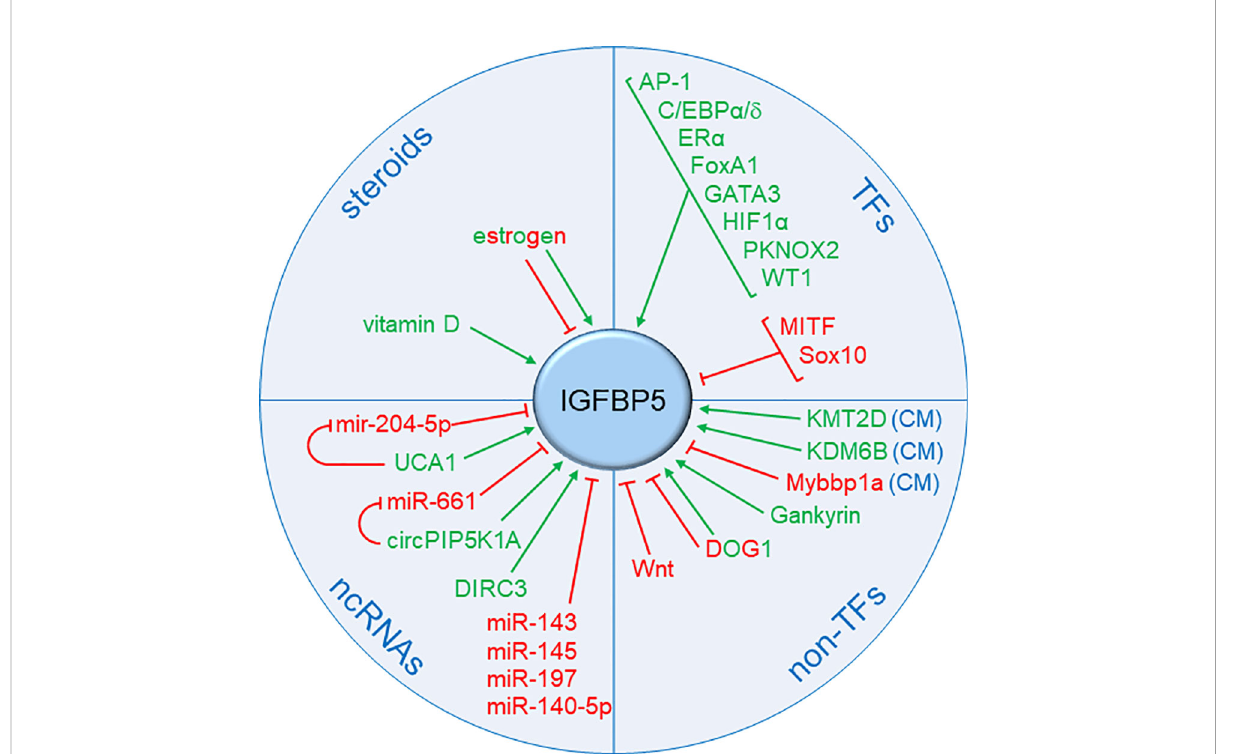
FIGURE 4 Summary of known factors regulating IGFBP5 expression. Besides proteins that regulate IGFBP5 transcription, namely transcription factors (TFs) (see also Figure 5) and chromatin modi fi ers (CM), other factors have been identi fi ed that interfere with IGFBP5 expression. These include other proteins (Wnt, DOG1, Gankyrin), steroids and non-coding RNAs (ncRNAs), namely microRNAs (miRs) and long noncoding RNAs (lncRNAs). Factors that stimulate IGFBP5 expression are denoted in green, those which have a negative effect are shown in red. Factors, which can have either effect dependent on the cellular context, are